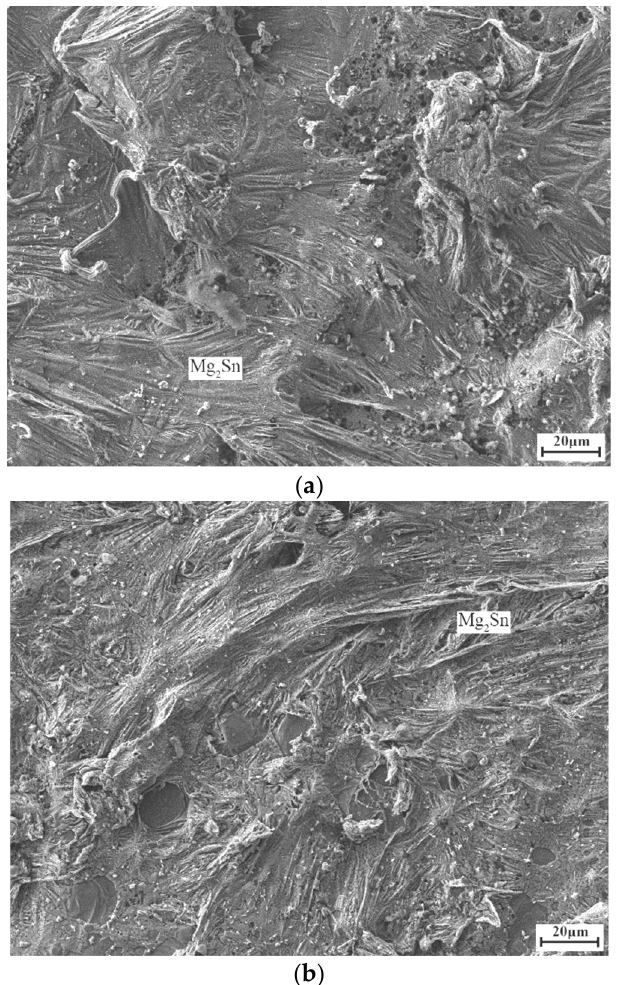
Figure 4. Fractography of the AZ31 magnesium alloy/6061 aluminum alloy joint bonded with the Sn-5Zn0.1-RE solder. ( a ) 6061 aluminum alloy side; ( b ) AZ31 magnesium alloy